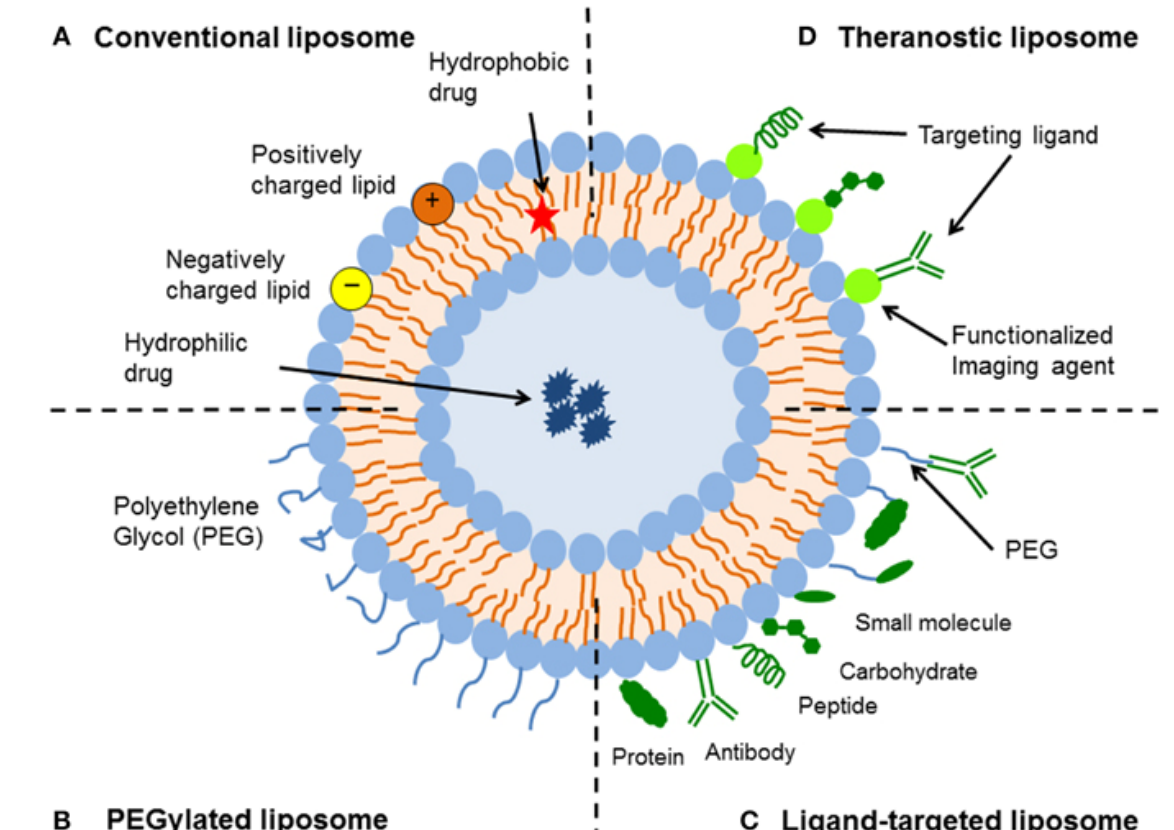
Figure 22. Schematic representations of a cross-section of an unilamellar vesicle with illustration of the possibilities for the functionalization of the vesicle surface for potential targeted drug delivery and theranostic applications, as published by Sercombe et al. (2015) [23]. For use as drug delivery systems, the possibilities for entrapping water-soluble (hydrophilic) and membrane-soluble (hydrophobic) drugs are also indicated. Other surface functionalities than the ones shown are also possible for non-pharmaceutical applications. The illustration is not drawn to scale as the diameter of the internal aqueous pool usually is considerably larger than the lipid bilayer thickness (often ~90 nm diameter and 4–5 nm membrane thickness). The possibility surface PEGylation is also indicated; see Figure 16b. Reproduced from [23], Frontiers,